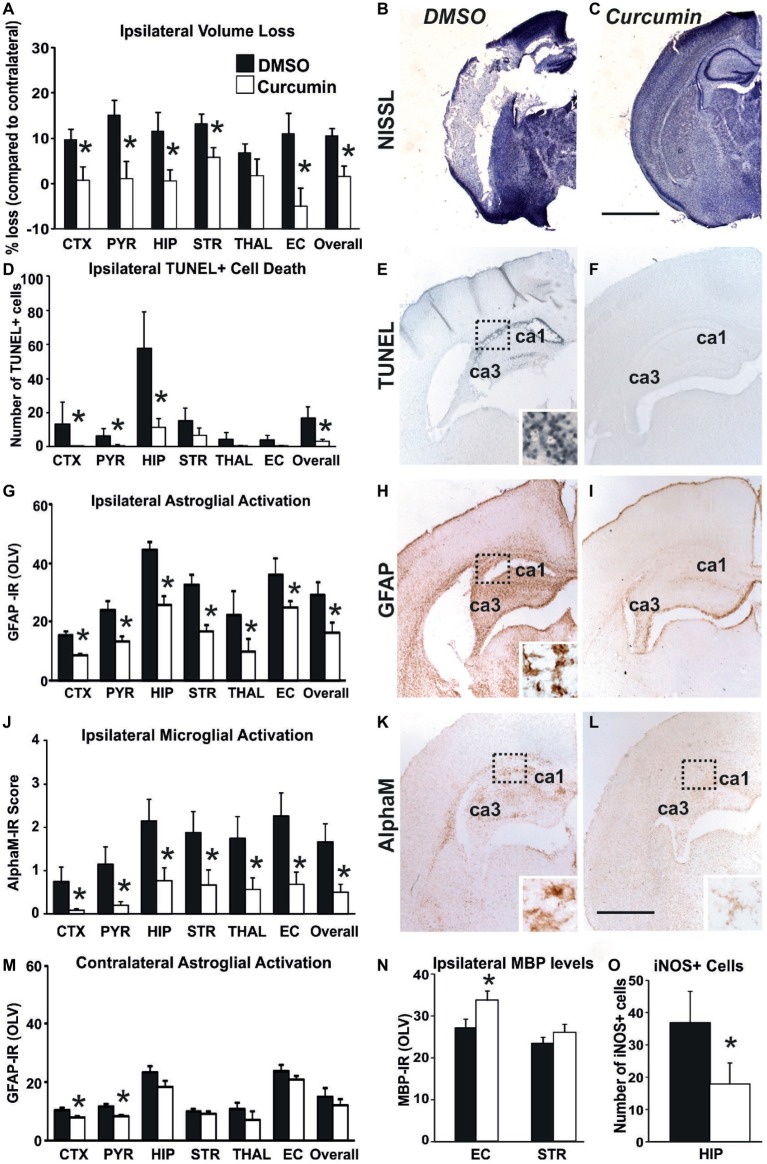
Intraperitoneal injection of curcumin (200 μg/g BW) in P7 mice immediately post-HI significantly reduces tissue damage, cell death and glial response. (A–C) Ipsilateral forebrain Nissl staining (Cresyl-Violet, at rostral parietal level) - Quantification of ipsilateral brain tissue volume loss (A) at 48 h following HI-insult of DMSO (B) and curcumin (C) treated animals at 48 h following HI-insult. Curcumin treatment (n = 11) reduced volume loss compared to DMSO-treated littermates (n = 11) with significant, individual decrease (t-test) in cortex (p = 0.026), pyriform cortex (p = 0.011), hippocampus (p = 0.038), striatum (p = 0.020), external capsule (p = 0.015) and overall volume loss (p = 0.003). Mixed Linear Model treating region as a repeated measure revealed p = 0.001. (D–F) TUNEL+ staining of dying brain cells with fragmented DNA at 48 h following HI-insult – Quantification (D) (number of TUNEL+ cells per 20× eye-field, Mean + SEM) and histochemical overview of the ipsilateral forebrain in DMSO (E) and curcumin (F) treated animals. Note the typical pyknotic nuclear morphology of the TUNEL+ cells observed in the DMSO group (E- insert, hippocampus) and the lack of such cells in the curcumin group (F). Curcumin treatment reduced TUNEL+ cell death across all 6 examined forebrain regions, with significant, individual decrease (t-test) in cortex (p = 0.04), pyriform cortex (p = 0.049), hippocampus (p = 0.046), and overall (p = 0.048). Mixed Linear Model treating region as a repeated measure revealed p = 0.036. (G–I,M) GFAP immunoreactivity at 48 h - Quantification of the ipsilateral (D) and contralateral, non-occluded side (M) in optical luminosity values (OLV, Mean + SEM), and low magnification ipsilateral overview in DMSO (H) and curcumin (I) treated animals. The insert in H shows higher magnification of the dotted region in rostro-parietal cortex. Note the reduced levels of GFAP immunoreactivity in the curcumin treated animals, with significant, individual decrease (t-test) in ipsilateral cortex (p = 4 × 10−5), pyriform cortex (p = 0.004), hippocampus (p = 0.049), striatum (p = 0.001), thalamus (p = 0.001), external capsule (p = 0.009) and overall (p = 0.048) in G, and in contralateral cortex (p = 0.01) and pyriform cortex (p = 0.0004) in M. Mixed Linear Model treating region as a repeated measure revealed p = 0.005 for the ipsilateral, and p = 0.0001 for the contralateral side. (J–L) Activation of αM+ microglia – Ipsilateral αM microglial activation score (J, Mean + SEM) and low magnification ipsilateral overview in DMSO (K) and curcumin (L) treated animals. Note the strong microglial activation in DMSO-treated animals with αM+ cells showing phagocytic morphology at high magnification (K-insert, hippocampus), compared to the curcumin treated brains exhibiting a ramified phenotype (L-insert). Curcumin treatment reduced αM+ microglial activation across all six examined forebrain regions, with significant, individual decrease (t-test) in cortex (p = 0.03), pyriform cortex (p = 0.01), hippocampus (p = 0.03), striatum (p = 0.04), thalamus (p = 0.04), external capsule (p = 0.01) and overall (p = 0.02). Mixed Linear Model treating region as a repeated measure p = 0.019. DMSO (n = 11) and curcumin (n = 11) in all assessments. (N) MBP immunoreactivity at 48 h - Quantification of the ipsilateral external capsule and striatum in optical luminosity values (OLV, Mean + SEM). Note the increased levels of MBP immunoreactivity in the curcumin treated animals, with significant, individual increase (t-test) in ipsilateral external capsule (p = 0.045). Mixed Linear Model treating region as a repeated measure p = 0.056. (O) iNOS immunoreactivity at 48 h – Quantification of the number of iNOS+ cells in ipsilateral hippocampus (number of iNOS+ cells per 20× eye-field, Mean + SEM). Note the reduced number of iNOS+ cells (t-test) in the curcumin treated group compared to DMSO-treated littermates (p = 0.041). (*p < 0.05). Abbreviations: CTX, cerebral cortex; EC, external capsule; HIP, hippocampus; PYR, pyriform cortex; STR, striatum; THAL, thalamus. Scale bars: (B,C) = 2,000 μm; (E,F,H,I,K,L) = 1,000 μm; inserts = 62 μm.